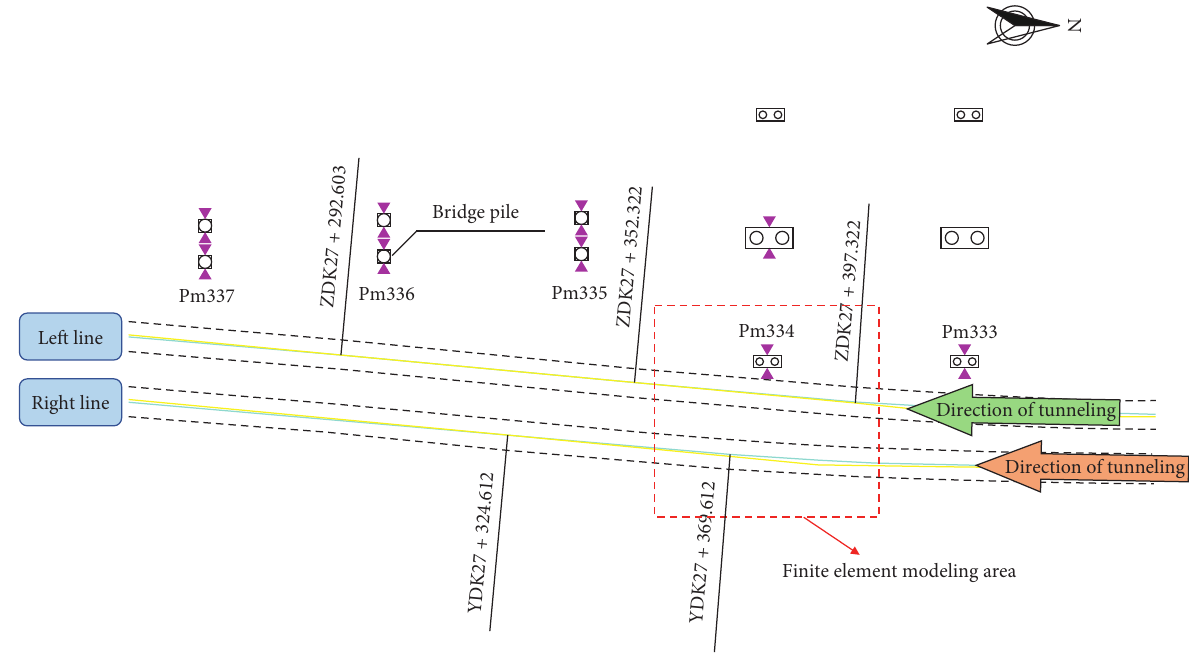
Figure 4: The monitoring layout of viaduct pier settlement.